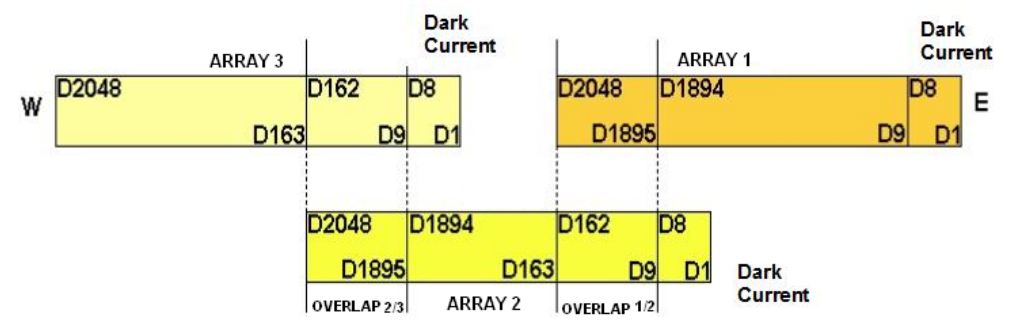
Figure 2. Structure of the CCD/CBERS-2B